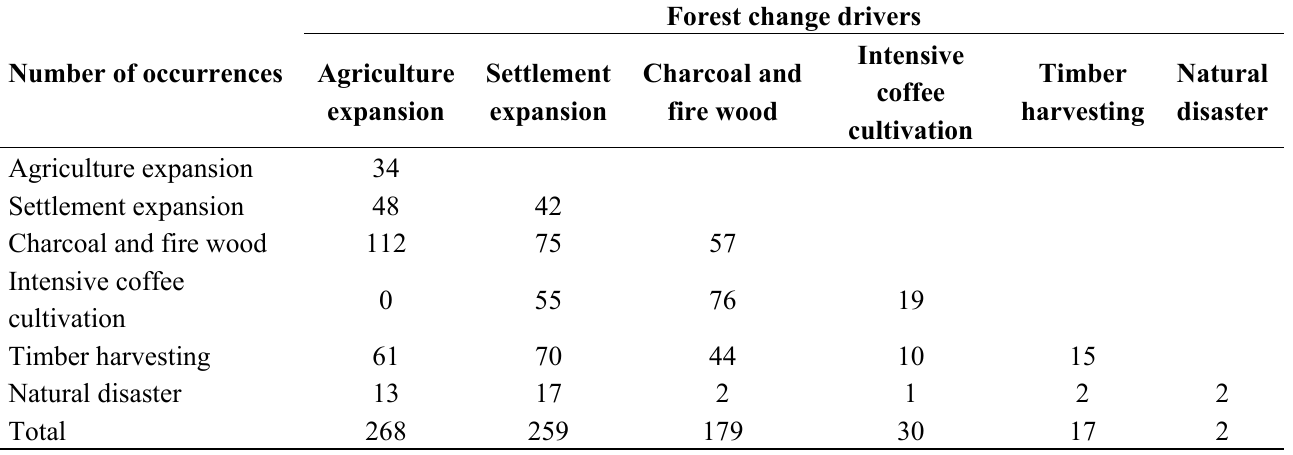
Table 4. Number of instances of the co-occurrence of forest change drivers. Numbers along the diagonal indicate the number of instances that a particular driver was reported